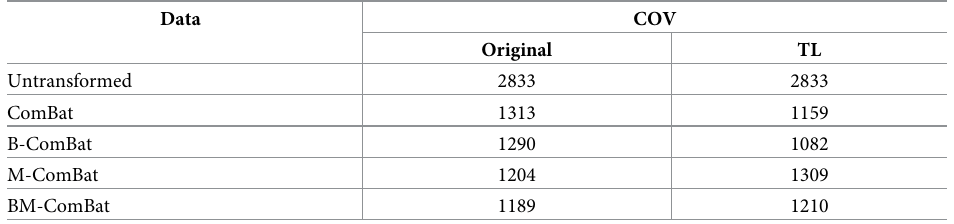
Table 1. COV computed on the Orig and TL data in four ComBat versions.